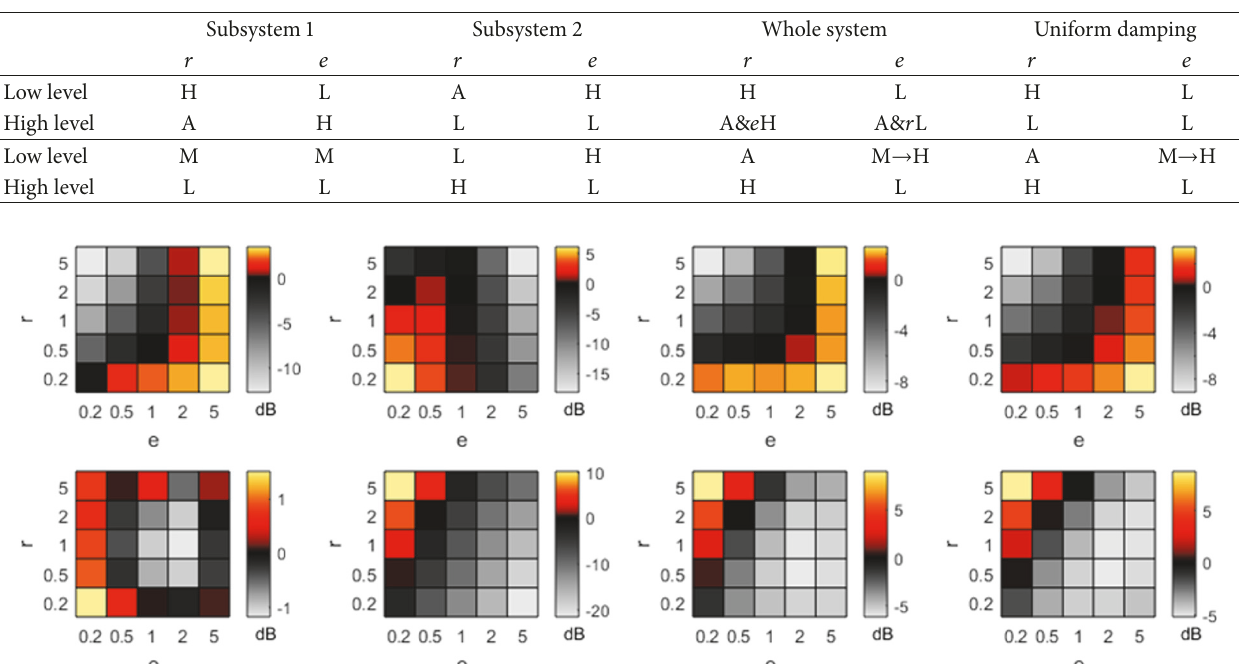
Table 1: Damping-averaged vibration level. Top: force-driven subsystem 1; bottom: acceleration-driven subsystem 2. Design value: L, low; M, medium; H, high; A, any.